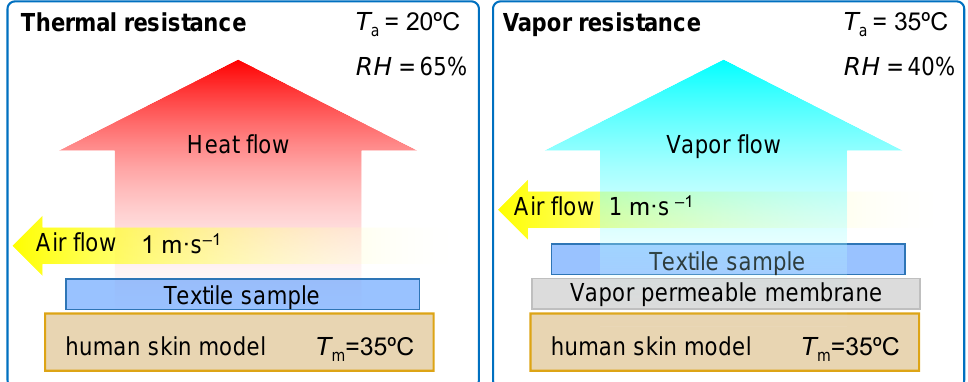
Figure 4. Conditions of the textile thermal and vapor resistance measurements. Thermal Insulation and Water Vapor Resistance (Newborn Manikin)